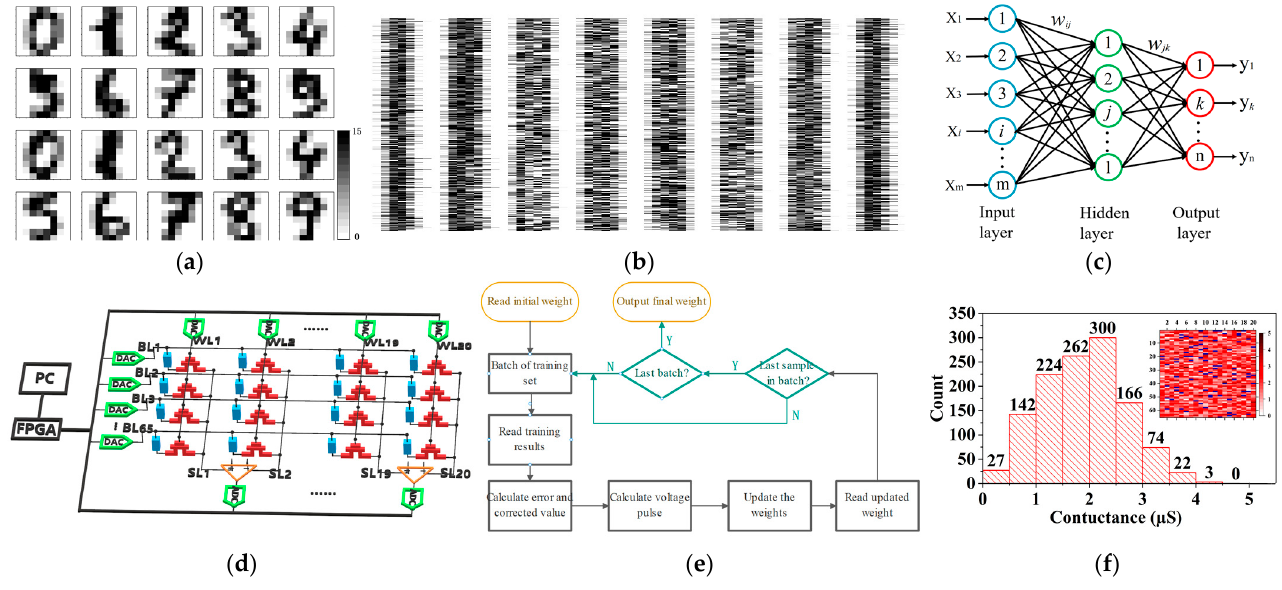
Figure 3. ( a ) Part of the handwritten digits from the MNIST and ( b ) the image storage converted to binary format. ( c ) The schematic diagram of the two-layer fully connected neural network structure. ( d ) The schematic diagram of the single layer fully connected neural network system structure. ( e ) The flow charts of synapse weight training. ( f ) The cumulative distribution of the conductance state of the memristor removing the failed unit; the inset shows the total conductance distribution diagram.